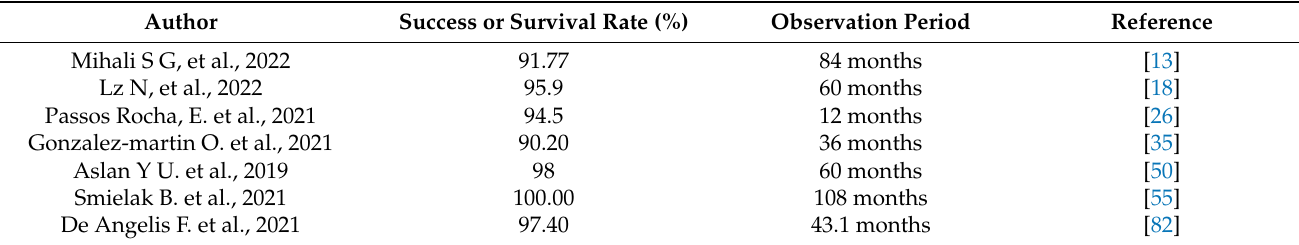
Table 5. The success or survival rate of